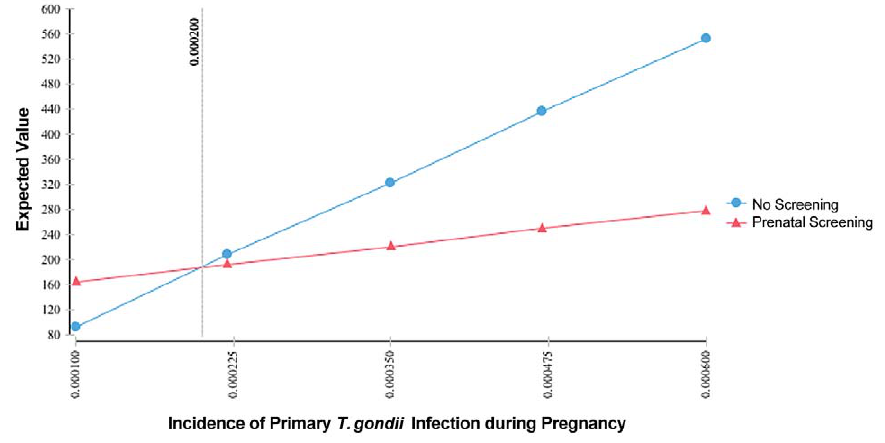
Figure 6. Sensitivity analysis of incidence of primary T.gondii infection during pregnancy (detail).